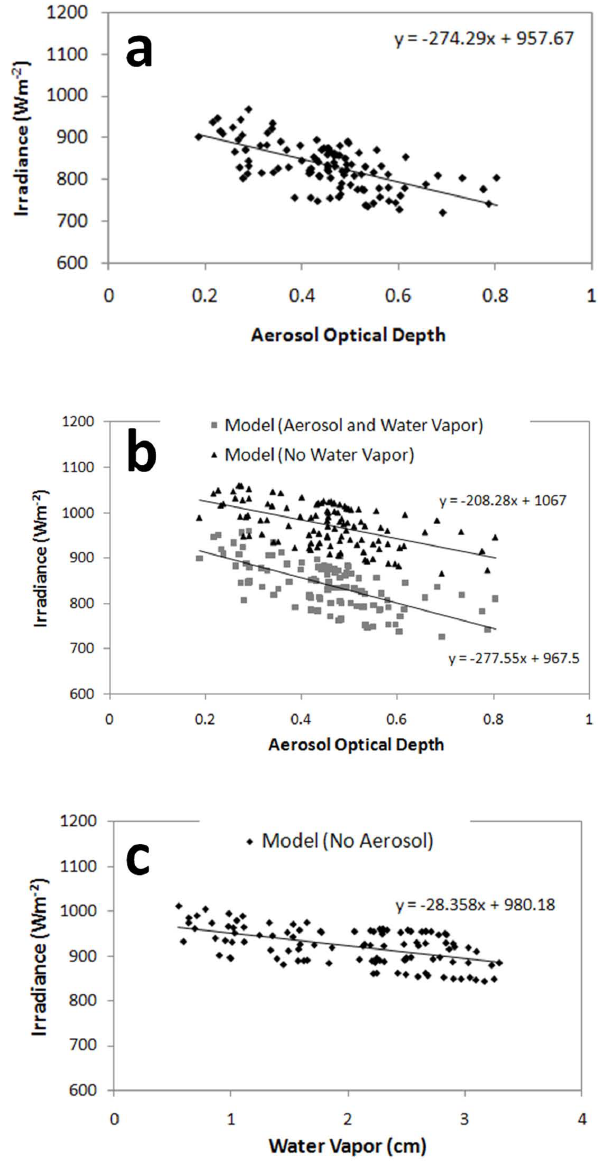
Fig. 11. ( a) Instantaneous forcing efficiency ( F e ) observed from pyranometer surface flux measurements over Jaipur at 25 ◦ –35 ◦ so- lar zenith angle, ( b) model calculated F e due to combined aerosol and water vapor radiative effect (black) and aerosol only with no water vapor input (grey), and ( c) model calculated water vapor F e . Aerosol and water vapor inputs to model calculations are obtained from CIMEL sunphotometer